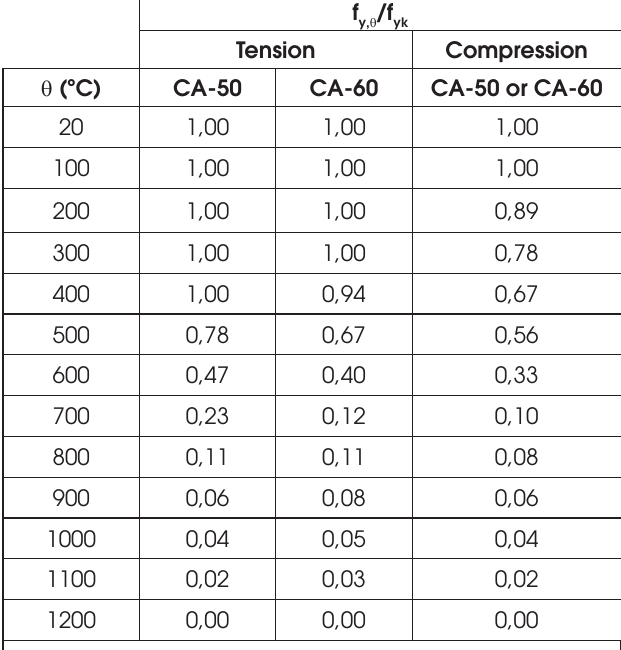
/f for reinforcing y, θ yk